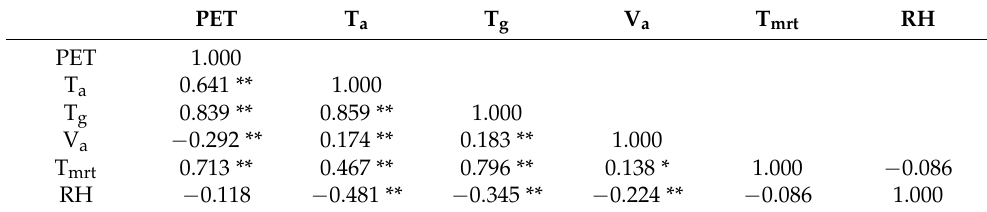
Table 6. Correlation analysis among microclimate